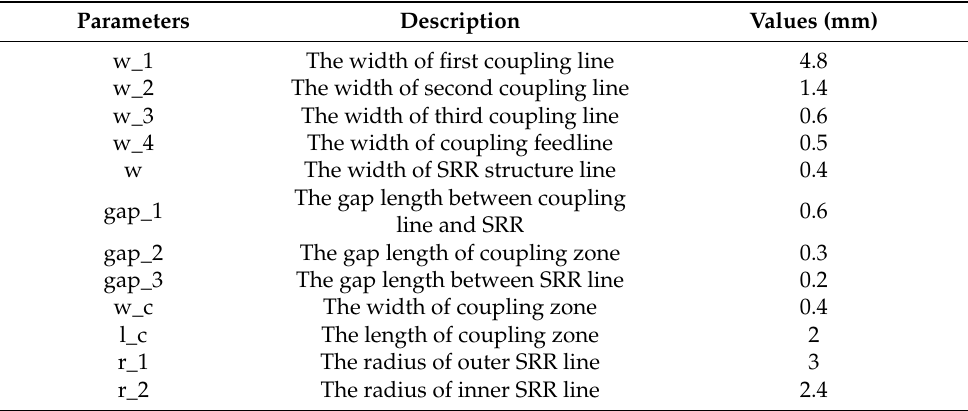
Table 1. Parameter values of the proposed microwave